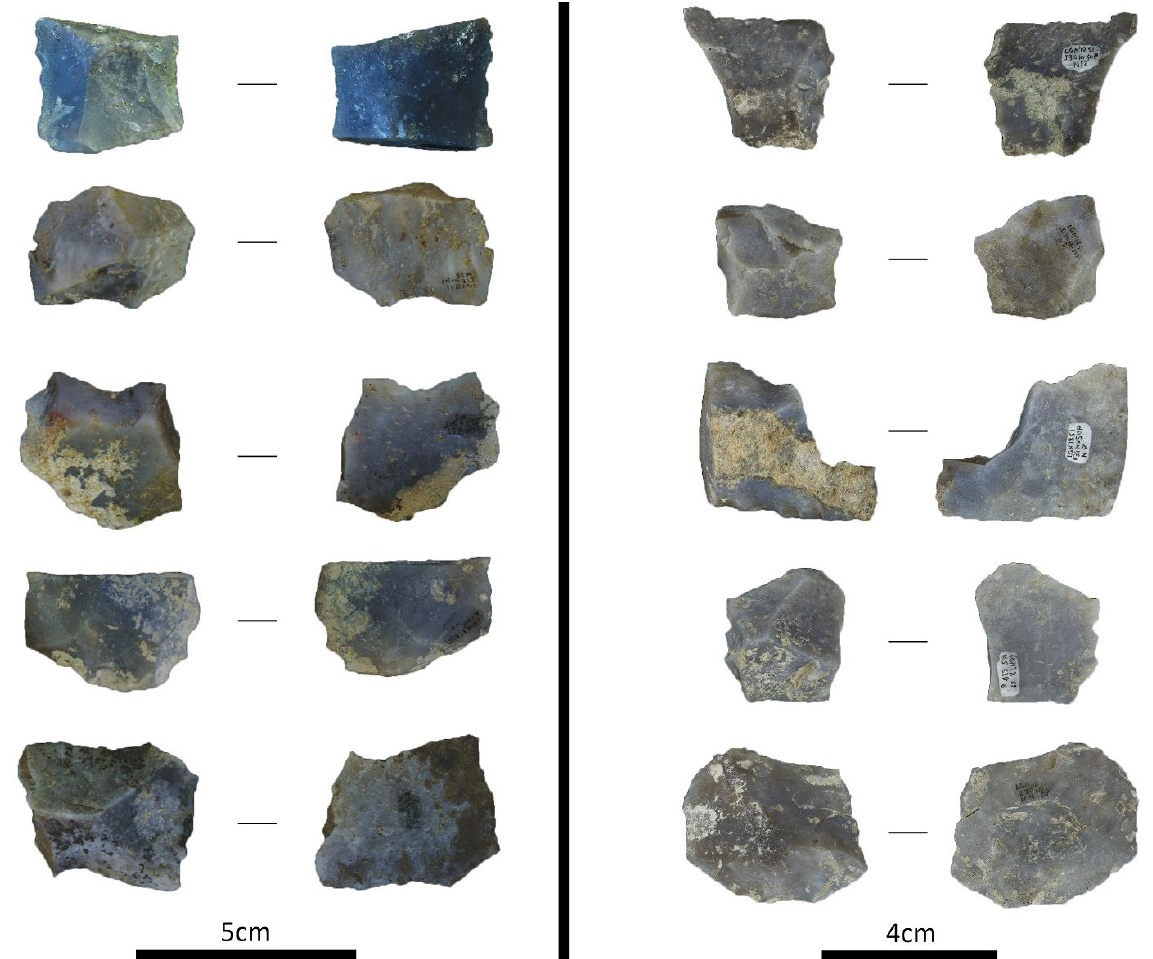
Figure 10. Gunflint preforms from LGN. A) Type 5 (LGN’18_sup_F28_6). B) Type 6b (LGN’18_sup_I28_20). C) Type 5 (LGN’18_sip_I27_5). D) Type 6b (LGN’18_sup_K30_2). E) Type 4 (LGN’18_sup_E29_16). F)